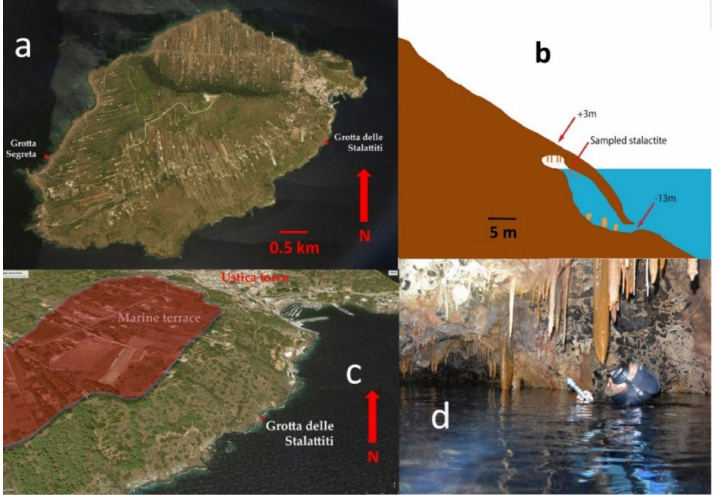
Figure 5. ( a ) Ustica and the location of the Grotta delle Stalattiti and Grotta Segreta caves. ( b ) Section of the Stalattiti cave. ( c ) Location of Stalattiti cave, Ustica town, and a well-carved marine terrace aged MIS 9 [53]. ( d ) Inside the cave at the sampling area, at sea level in an air